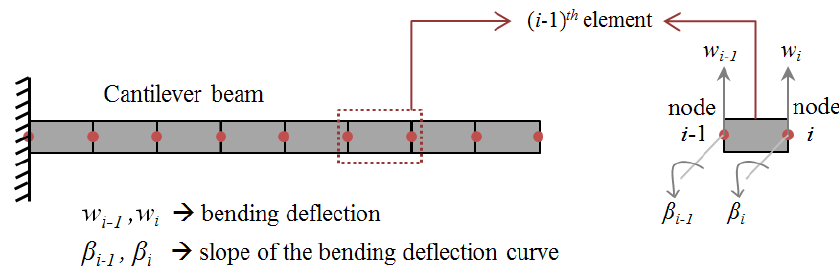
Figure 4. FEM model of the cantilever